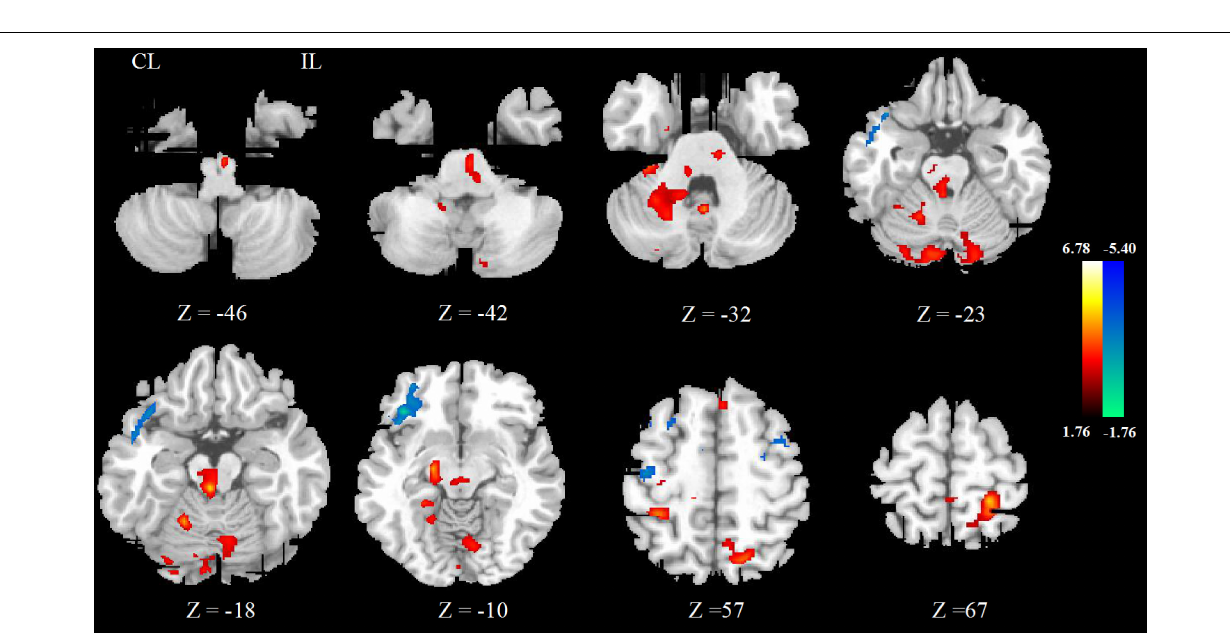
Frontiers in Human Neuroscience |